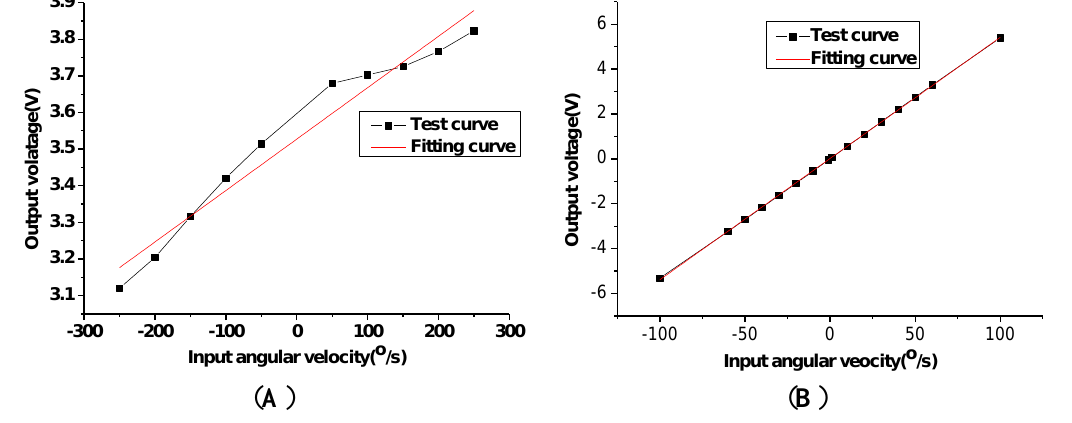
Figure 16. Scale factor comparison test in different installation error. ( A ) The first generation with a large installation error (Open-loop). ( B ) The second generation with a small installation error (Open-loop).